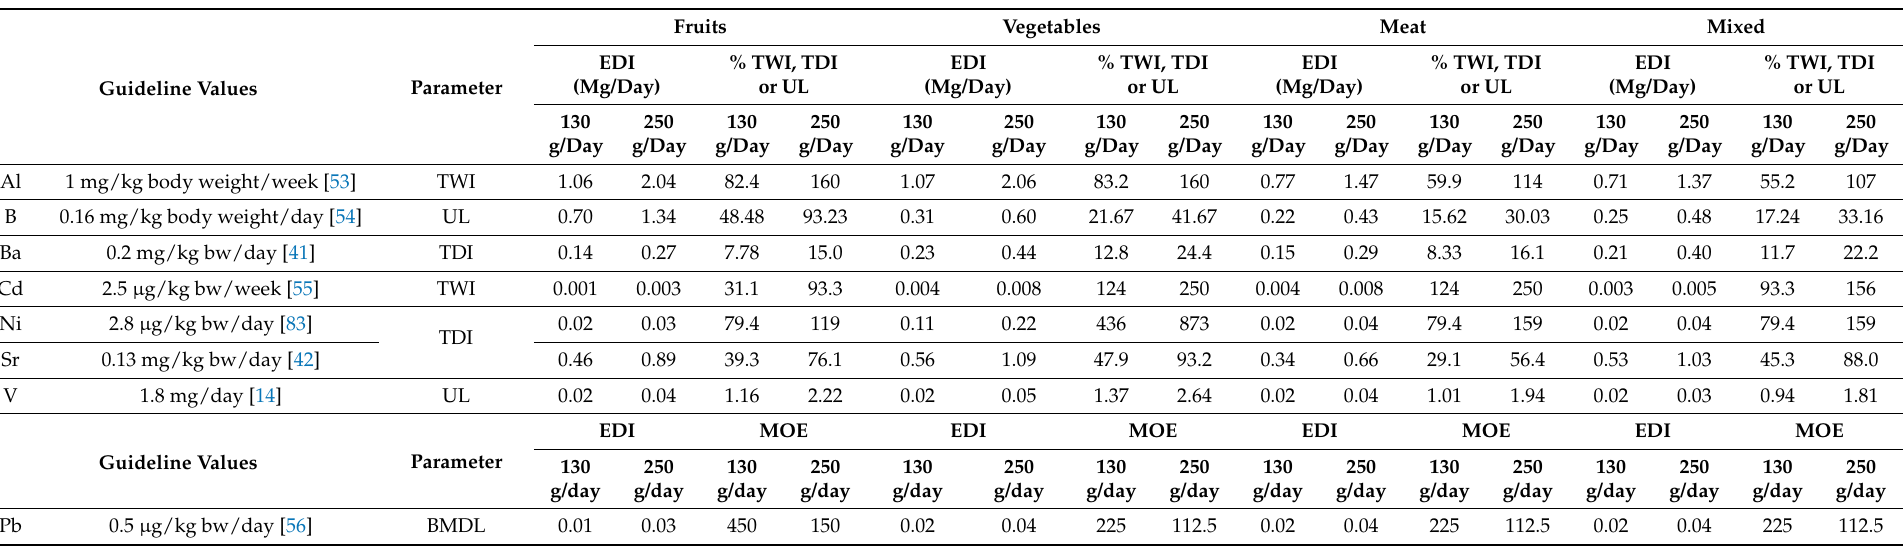
Table 8. Estimated daily intake (mg/day) and percentages of contribution to the tolerable weekly intake (TWI), tolerable daily intake (TDI) or upper level intake (UL) of the studied toxic elements considering a consumption of 130 g/day and 250 g/day of baby food from